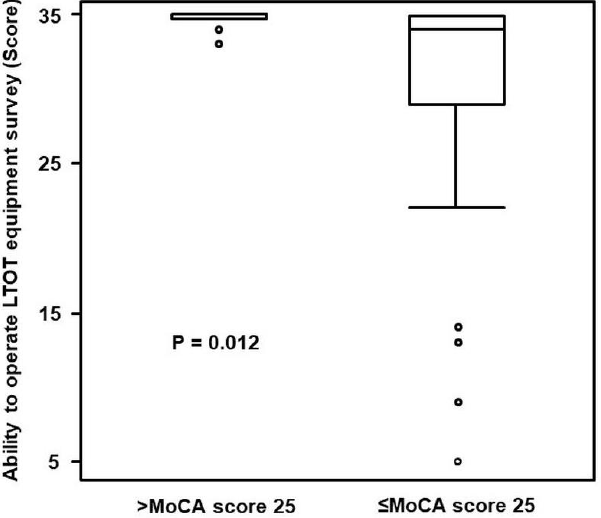
Figure 1. Comparison of Montreal Cognitive Assessment (MoCA) score ≤ 25 or >25 and the ability to operate long-term oxygen therapy equipment. The group of MoCA score ≤ 25 exhibited a lower ability to operate long-term oxygen therapy (LTOT) equipment survey than the group of MoCA score > 25 ( p = 0.012).